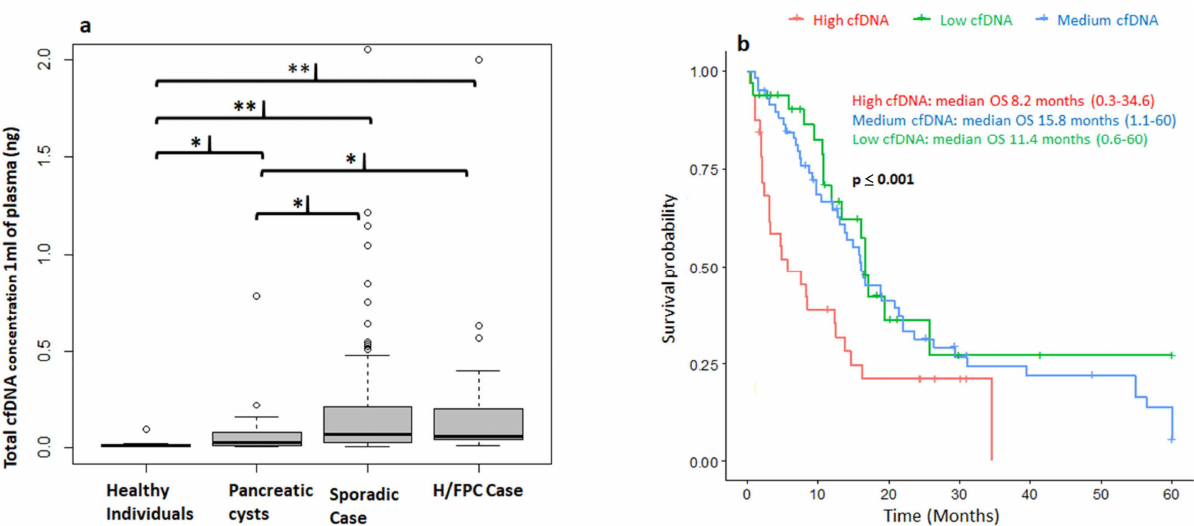
Figure 1. Correlation of circulating free DNA (cfDNA) levels with clinical characteristics. ( a ) The concentration of circulating free DNA (cfDNA) in plasma differentiates between cancer and non-cancer cases. There were significantly higher levels of total cfDNA in hereditary or familial and sporadic pancreatic ductal adenocarcinoma (PDAC) cases compared to healthy controls and patients with pancreatic cysts. ** p ≤ 0.01; * p ≤ 0.05. ( b ) High levels of cfDNA at diagnosis correlate with a poorer overall survival (OS). Patients were classified into 3 groups: high (>0.2037 ng), medium ( ≥ 0.035 ng and ≤ 0.2037), and low (<0.035 ng) cfDNA levels. Follow-up was censored at 5 years and adjusted for sex, age, and disease stage at diagnosis, sporadic or hereditary and familial, case and first line treatment. Low: N = 33; Medium N = 67 and High: N =